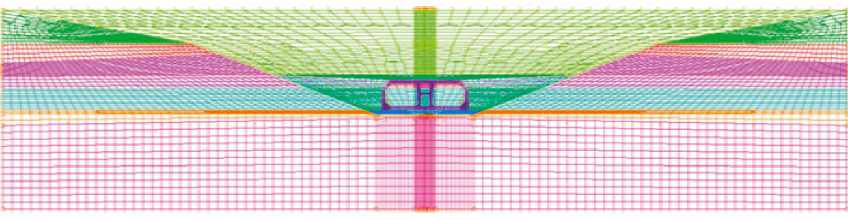
Figure 12: Grid partition schematic diagram.